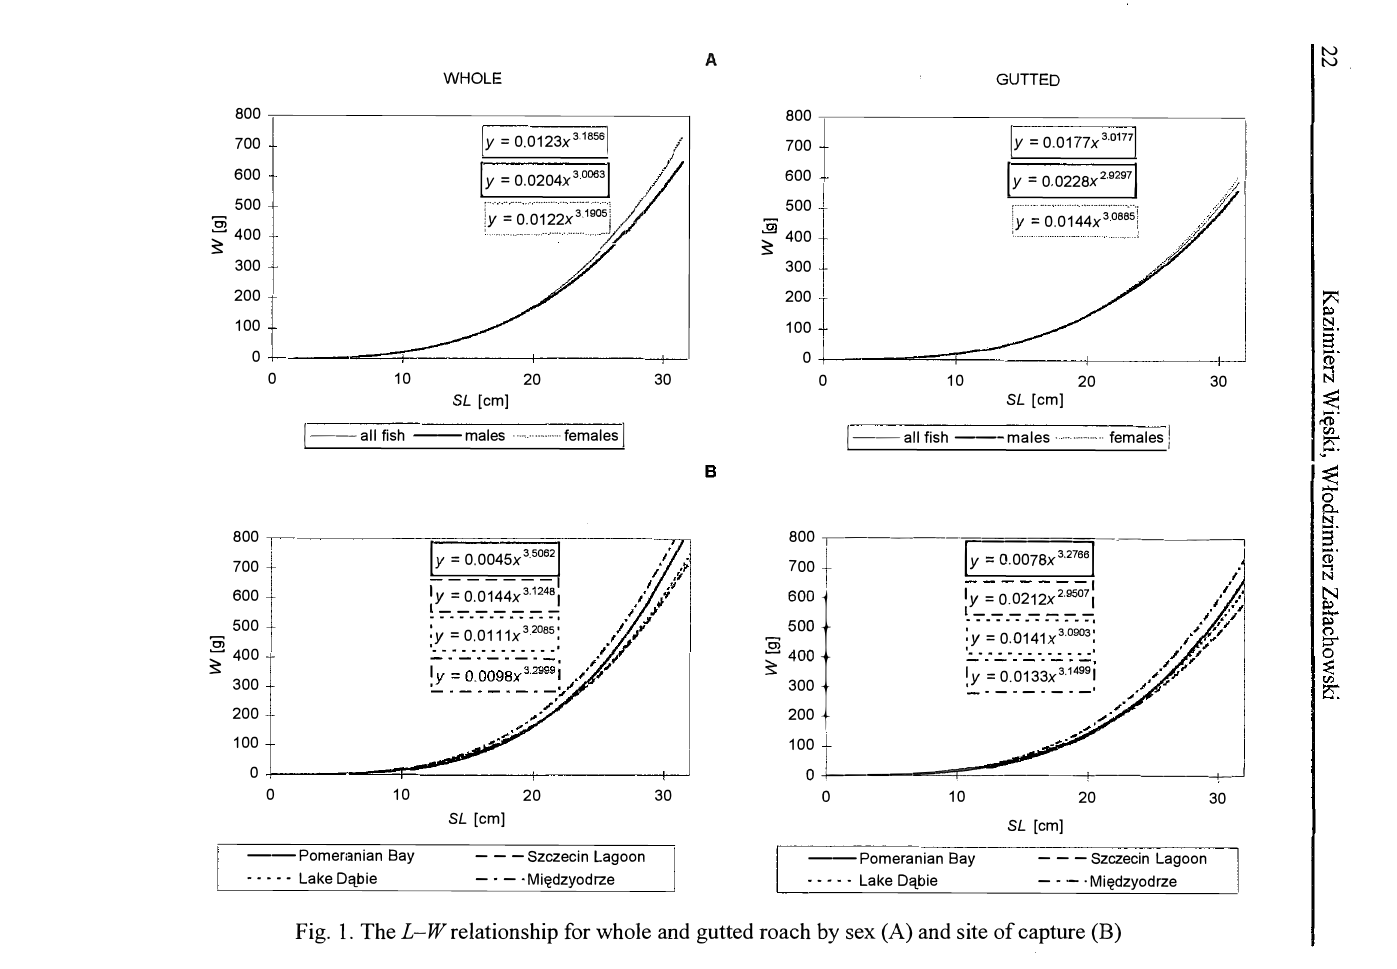
Fig. 1. The L-W relationship for whole and gutted roach by sex (A) and site of capture